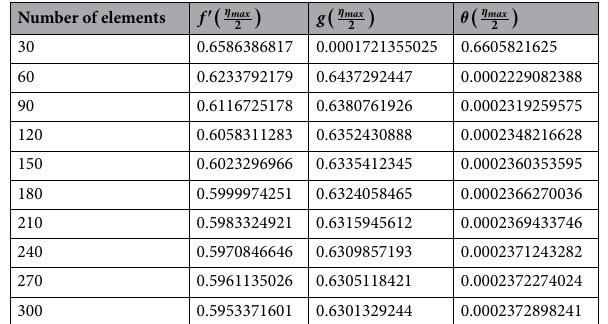
Table 2. Simulations of mesh free analysis for velocities and temperature when ∅ 1 = (cid:31) = 0.3, β e = 0.3, α = 2.0, β i = 0.002, β = 0.2, Pr = 206, Ec = 3.2, H s = 0.2, M = 0.01.